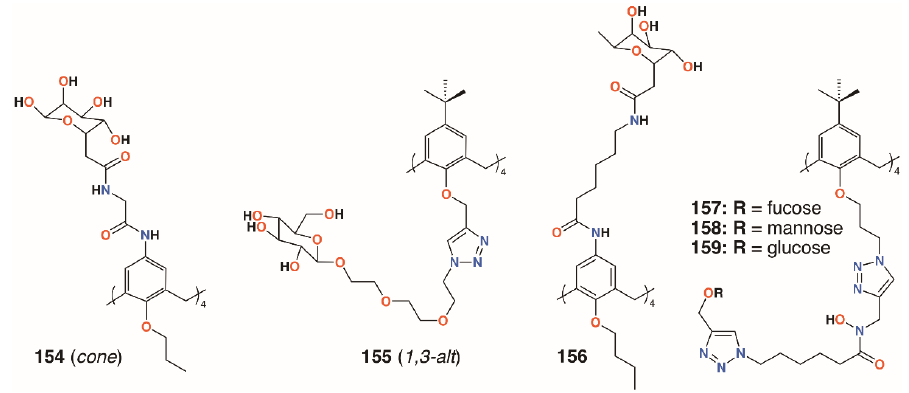
Figure 23. Glycosylated calixarenes from Geraci, Vidal, and Benazza.